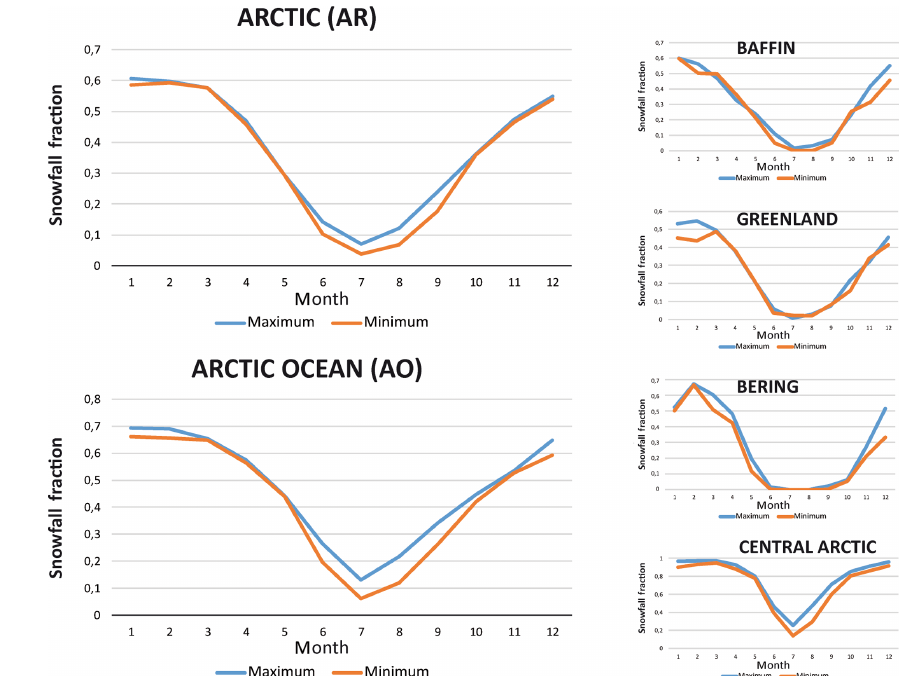
Figure 10. Snowfall fraction taken from the ERA-Interim reanalysis by month for the AR, the AO, and the four more important AO subregions as a percentage of MTP as identified by Gimeno-Sotelo et al. (2018): Baffin, Greenland, Bering, and central Arctic. The blue line represents the fraction for high-SIE years and the red line for low-SIE years, with the snowfall fraction being higher for high years in almost all months but especially in